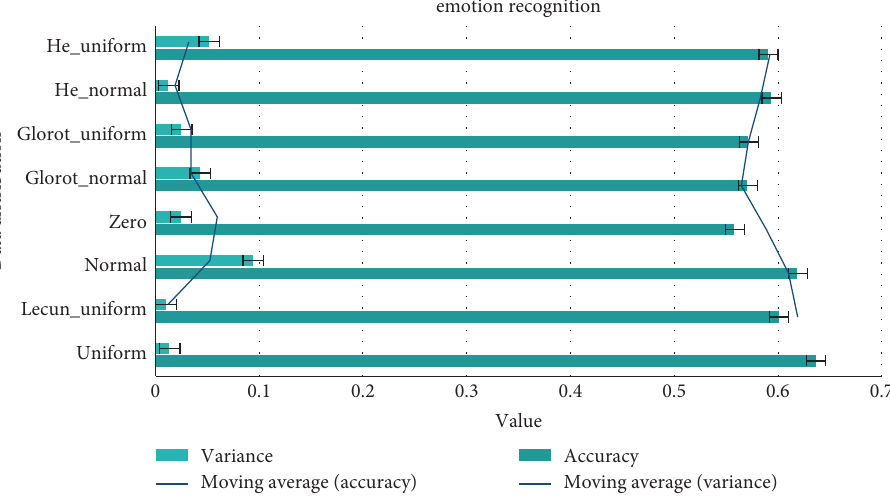
Figure 3: The impact of different initialization weight vectors on the accuracy of emotion recognition. Table 4: The parameters of the convolutional neural network.